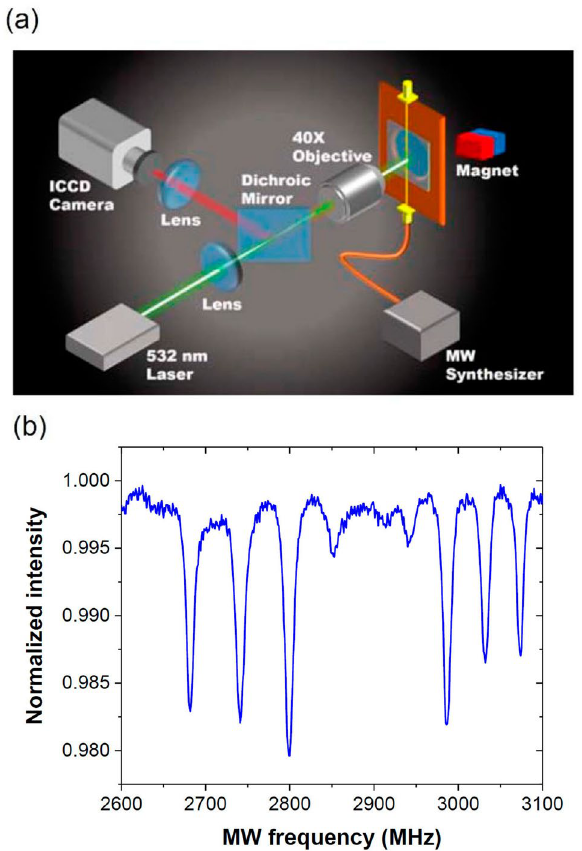
Figure 3. ( a ) Schematic diagram of the experimental setup. The sample consists of a diamond microcrystal containing a dense ensemble of NV − centers. ( b ) Typical normalized ODMR spectrum of the NV − centers in FMD, acquired in the presence of an external magnetic field of B (cid:31) = 6.6